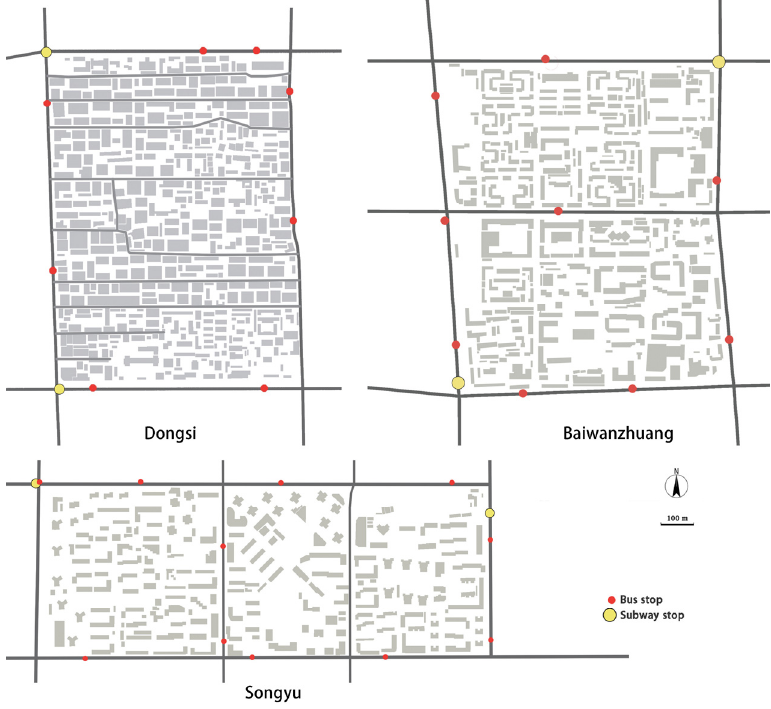
Figure 3. Bus and subway stops in the neighborhoods.